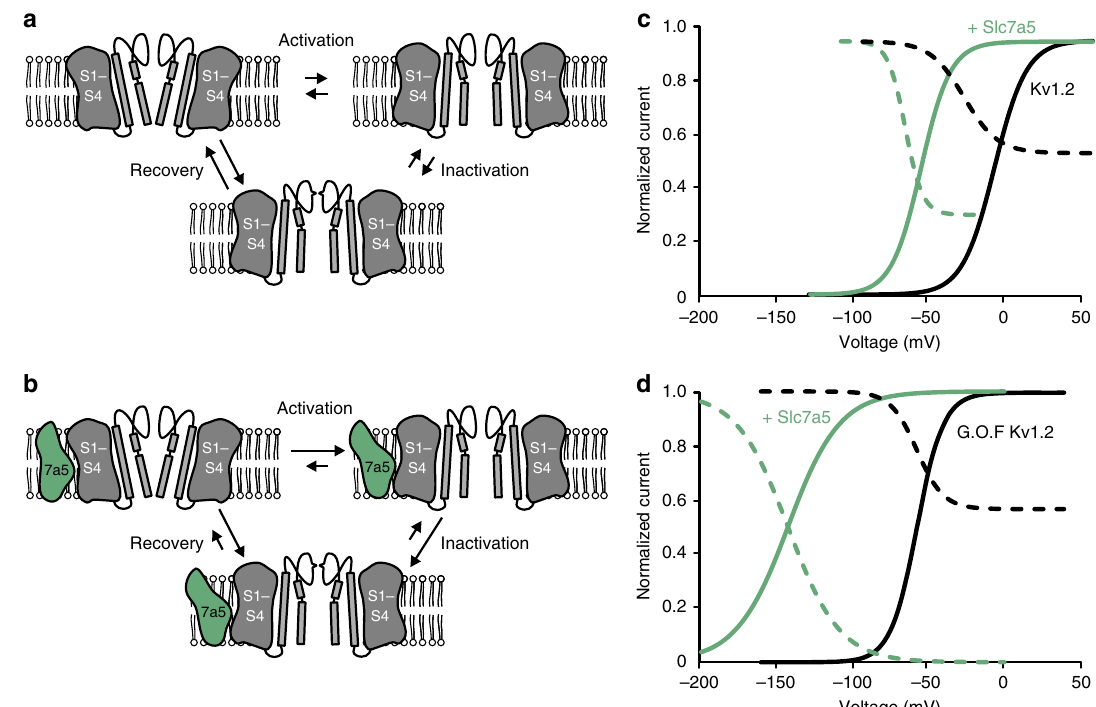
Fig. 10 Inactivation trap gating effect of Slc7a5 on Kv1.2. a Generic gating scheme of Kv1.2 cycling between closed, activated, and inactivated states. b Slc7a5 accelerates channel activation and inactivation, and slows recovery from inactivation, leading to accumulation of channels in an inactivated state. c Activation curves from Fig. 4 and inactivation curves from Fig. 5 are shown, illustrating the greater propensity for inactivation of Kv1.2 when assembled with Slc7a5. d Disease-linked gain-of-function mutants (GoF Kv1.2) exhibit greatly exaggerated sensitivity to Slc7a5 gating effects, such that Kv1.2 channels in complex with Slc7a5 are predominantly inactivated at resting voltages. Activation curves are reproduced from Fig. 9e. Inactivation curves are hypothesized, as they could not be measured due to the extreme voltages